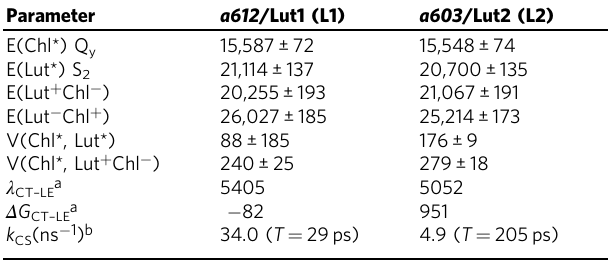
Table 1 Energies and couplings in the Lut – Chl dimers.